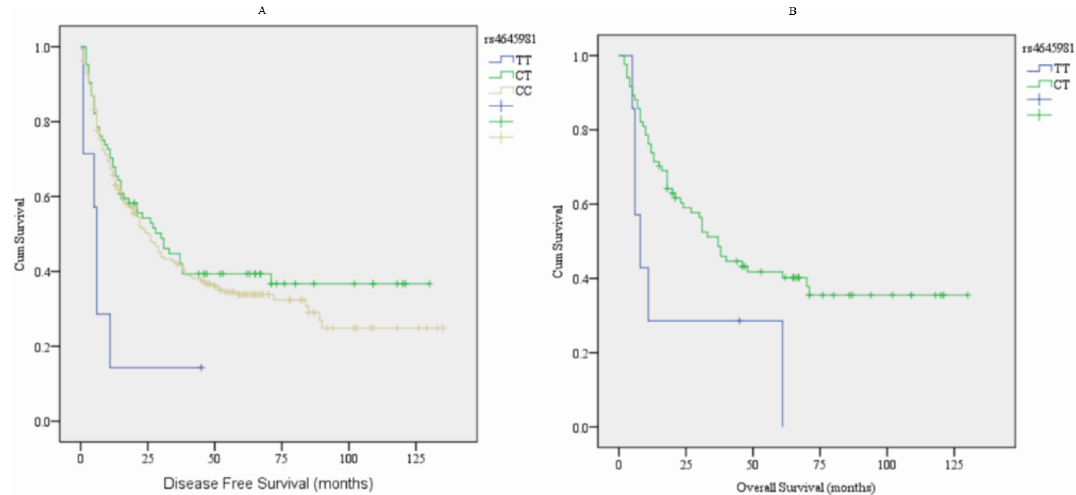
Fig 1. Kaplan-Meier survival curves of CASP9 rs4645981 with clinical outcomes of 362 HCC patients. (A) disease free survival (DFS) (B) overall survival (OS).